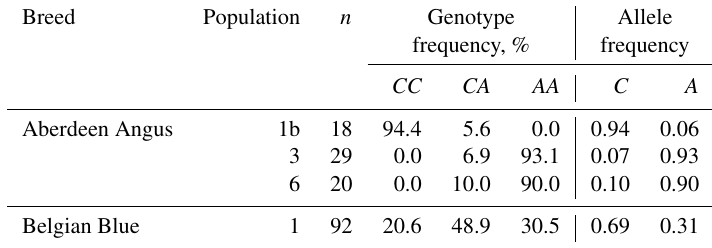
Table 4. The results of the genotyping of Aberdeen Angus and Belgian Blue cattle for the F94L MSTN polymorphism.